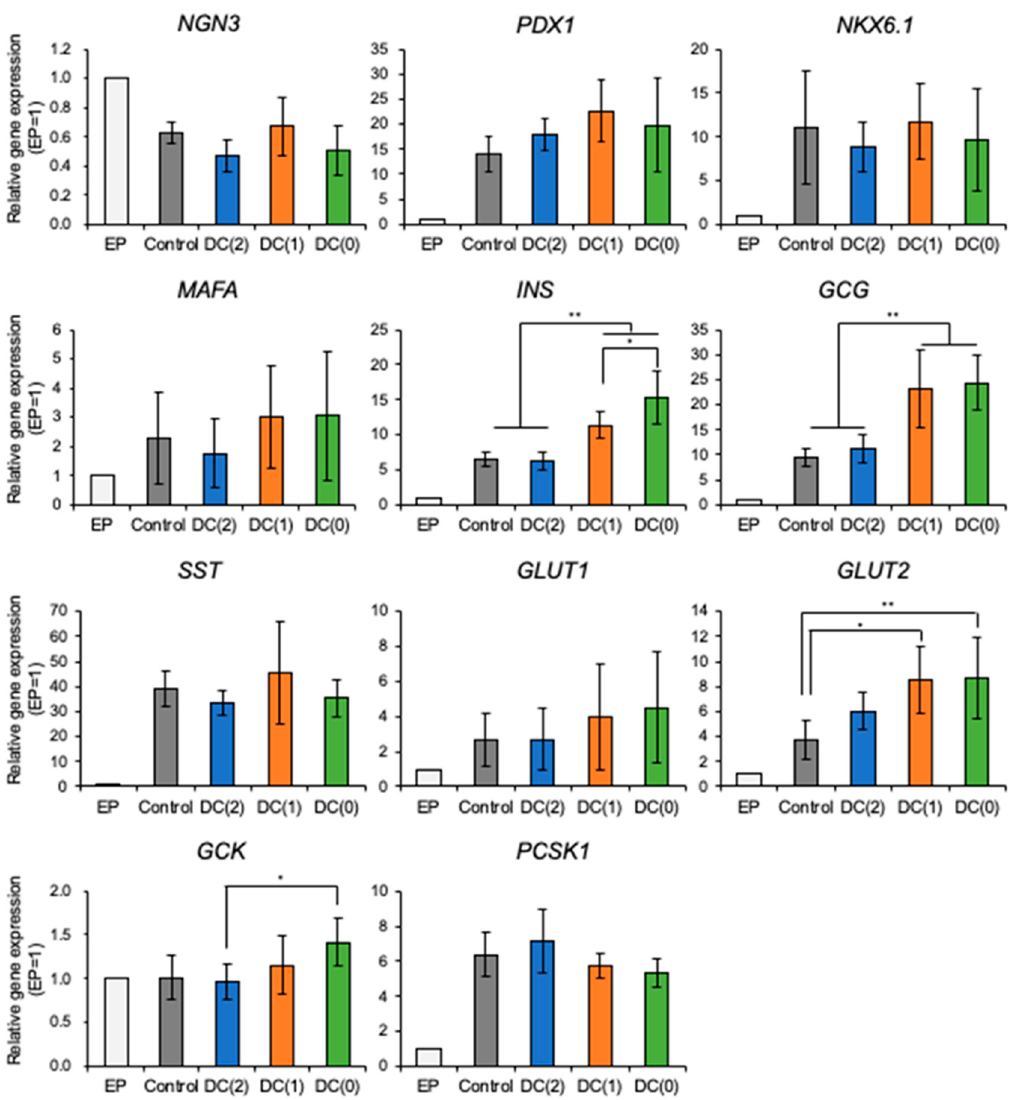
Figure 4. Relative gene expression levels of NGN3 , PDX1 , NKX6.1 , MAFA , INS , GCG , SST , GLUT1 , GLUT2 , GCK , and PCSK1 in differentiated EP cells and islet-like cells were measured by RT-qPCR. Data represent mean ± SD of n = 5–6 from two independent experiments. Statistical analysis as determined by one-way ANOVA with post hoc Tukey HSD test. (* p < 0.05, ** p <